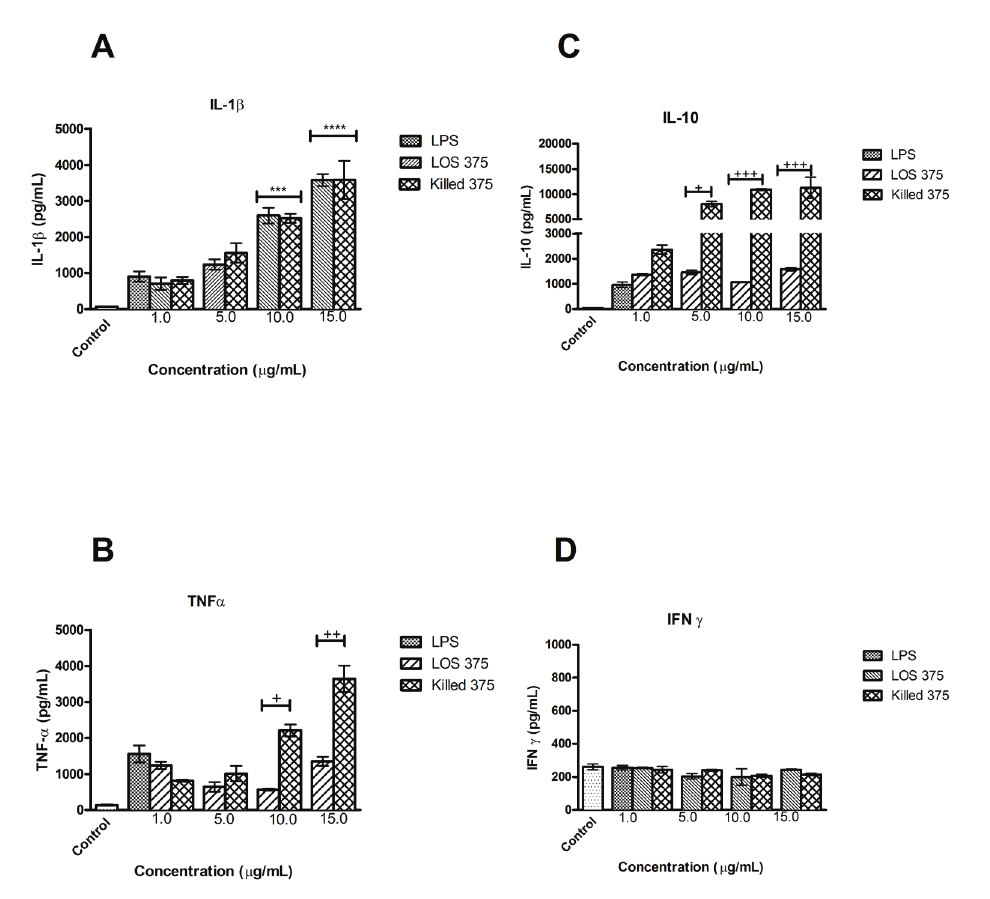
Figure 4. Cytokine release from differentiated THP-1 cells stimulated with NTHi LOS or killed NTHi for 24 hours. THP-1 cells were stimulated with LOS at concentrations of 1, 5, 10, and 15 μg/ml, or correspond- ing amounts of killed NTHi 375: 4.762 × 10 7 , 2.381 × 10 8 , 4.762 × 10 8 , 7.143 × 10 8 CFU per 1 × 10 6 cells. Unstimulated differentiated THP-1 cells (1 × 10 6 ) in complete culture medium served as a negative control; cells stimulated with 1 μg/ml of E. coli LPS served as a positive control. Concentrations of IL-1β (A), TNFα (B), IL-10 (C), and IFNγ (D) were measured by ELISA. Data represents mean cytokine concentration ± SEM (n = 3). *, P < 0.05 compared to LPS; +, P < 0.05 between LOS and killed